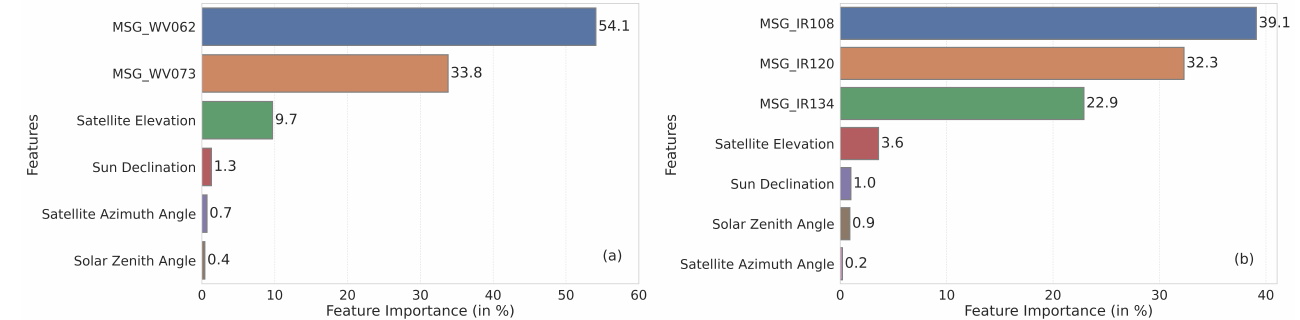
Figure 11. Feature importance for all the input predictors used in ( a ) WV and ( b ) IR model. The x-axis shows the feature importance (in %) and the y-axis shows the corresponding name of input variables.